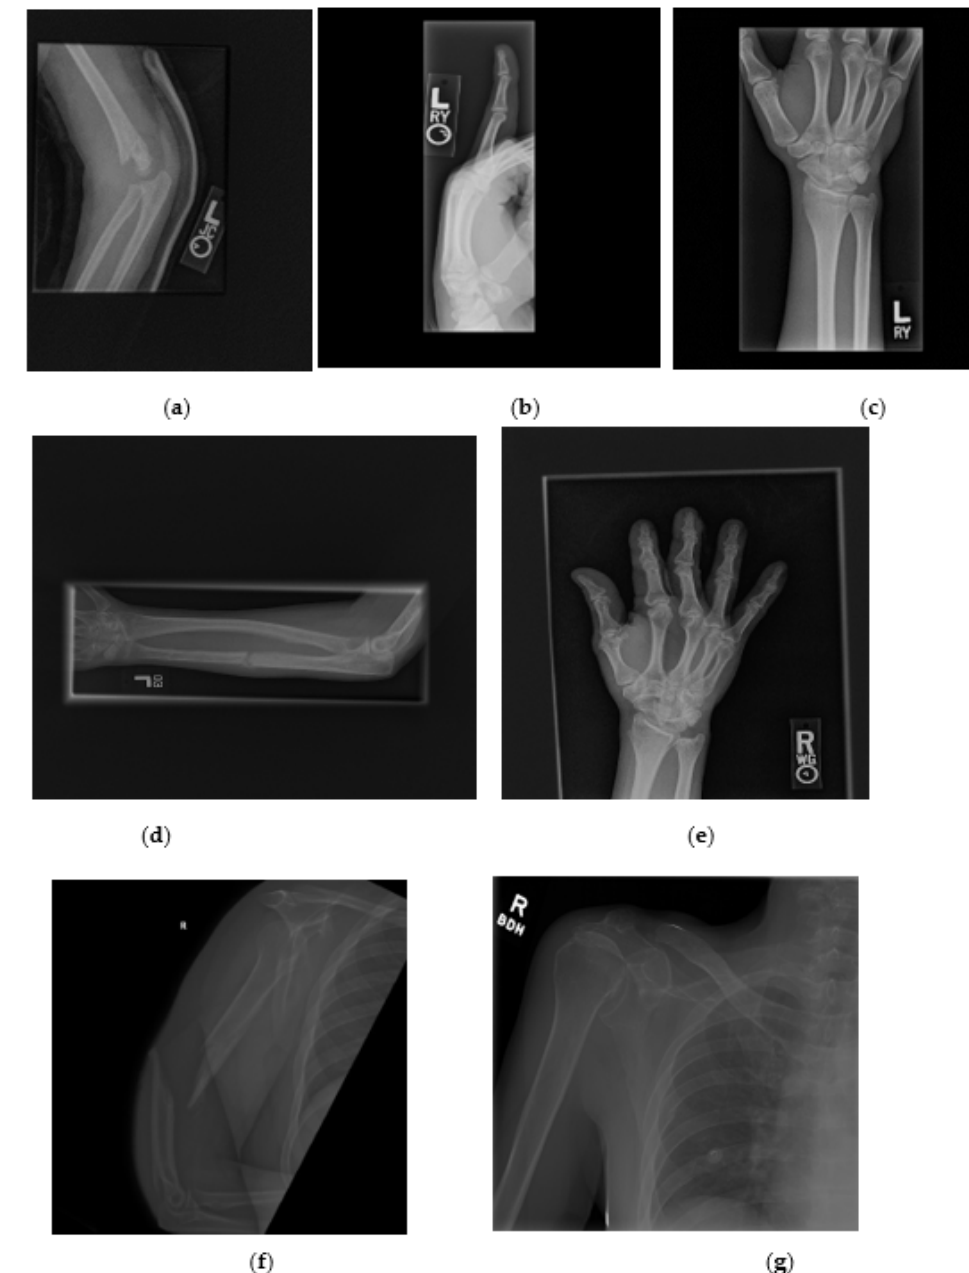
Figure 3. Samples of each fracture type from MURA dataset: ( a ) Fractured elbow. ( b ) Fractured finger. ( c ) Fractured wrist. ( d ) Fractured forearm. ( e ) Fractured hand. ( f ) Fractured humerus. ( g ) Fractured shoulder.